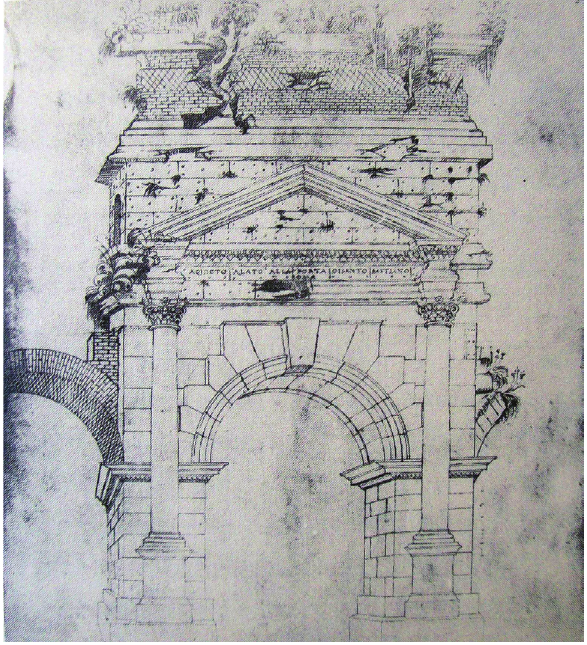
Figure 2. Rome. The Arch of Drusus drawing by Giuliano da Sangallo, 1480 ca. (from